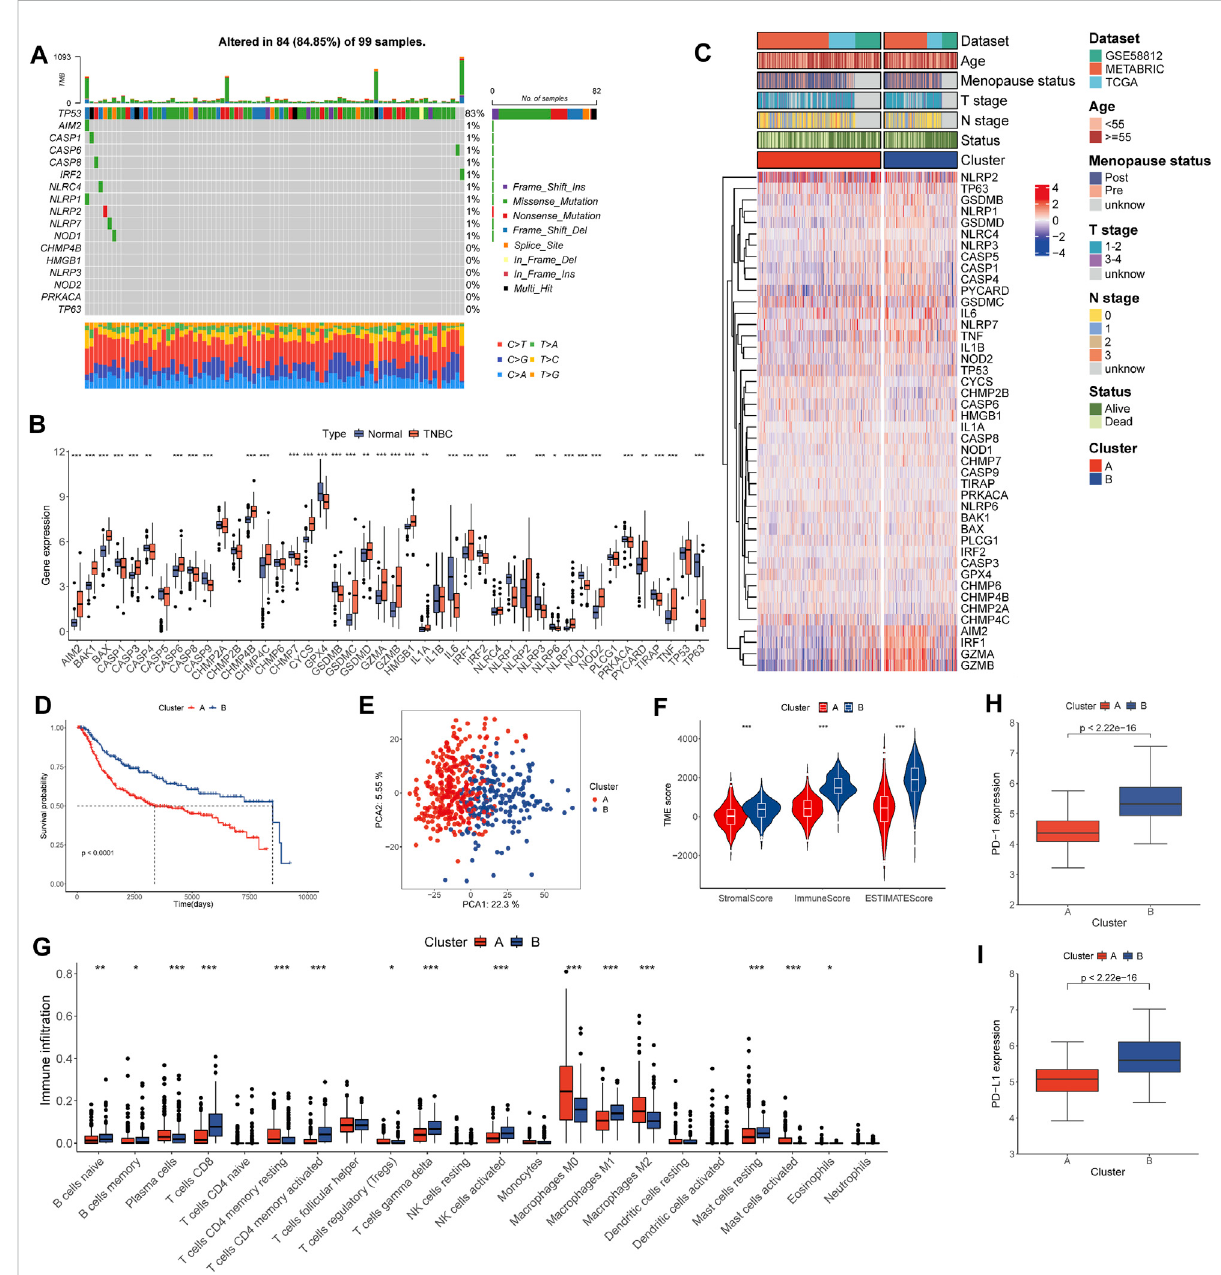
FIGURE 2 Landscape of genetic and transcriptional alterations and pyro-clusters inpatients with TNBC. (A) Genetic alteration of PRGs in 99 patients from TCGA cohort. (B) Distribution of 44 PRG expression in normal and TNBC tissues. (C) Heat map of clinicopathologic features and expression of PRGs between two distinct clusters. (D) Kaplan – Meier curves of OS for TNBC patients of the two distinct clusters. (E) PCA analysis showing the marked difference in transcriptomes across pyro-clusters. (F) Correlations between pyro-clusters and the TME score. (G) Abundance of 22 in fi ltrating immune cell types in the two pyro-clusters. (H) Expression \ of PD-1 in the two pyro-clusters. (I) Expression of PD-L1 in the two pyro-clusters. * p < 0.05, ** p < 0.01, *** p <